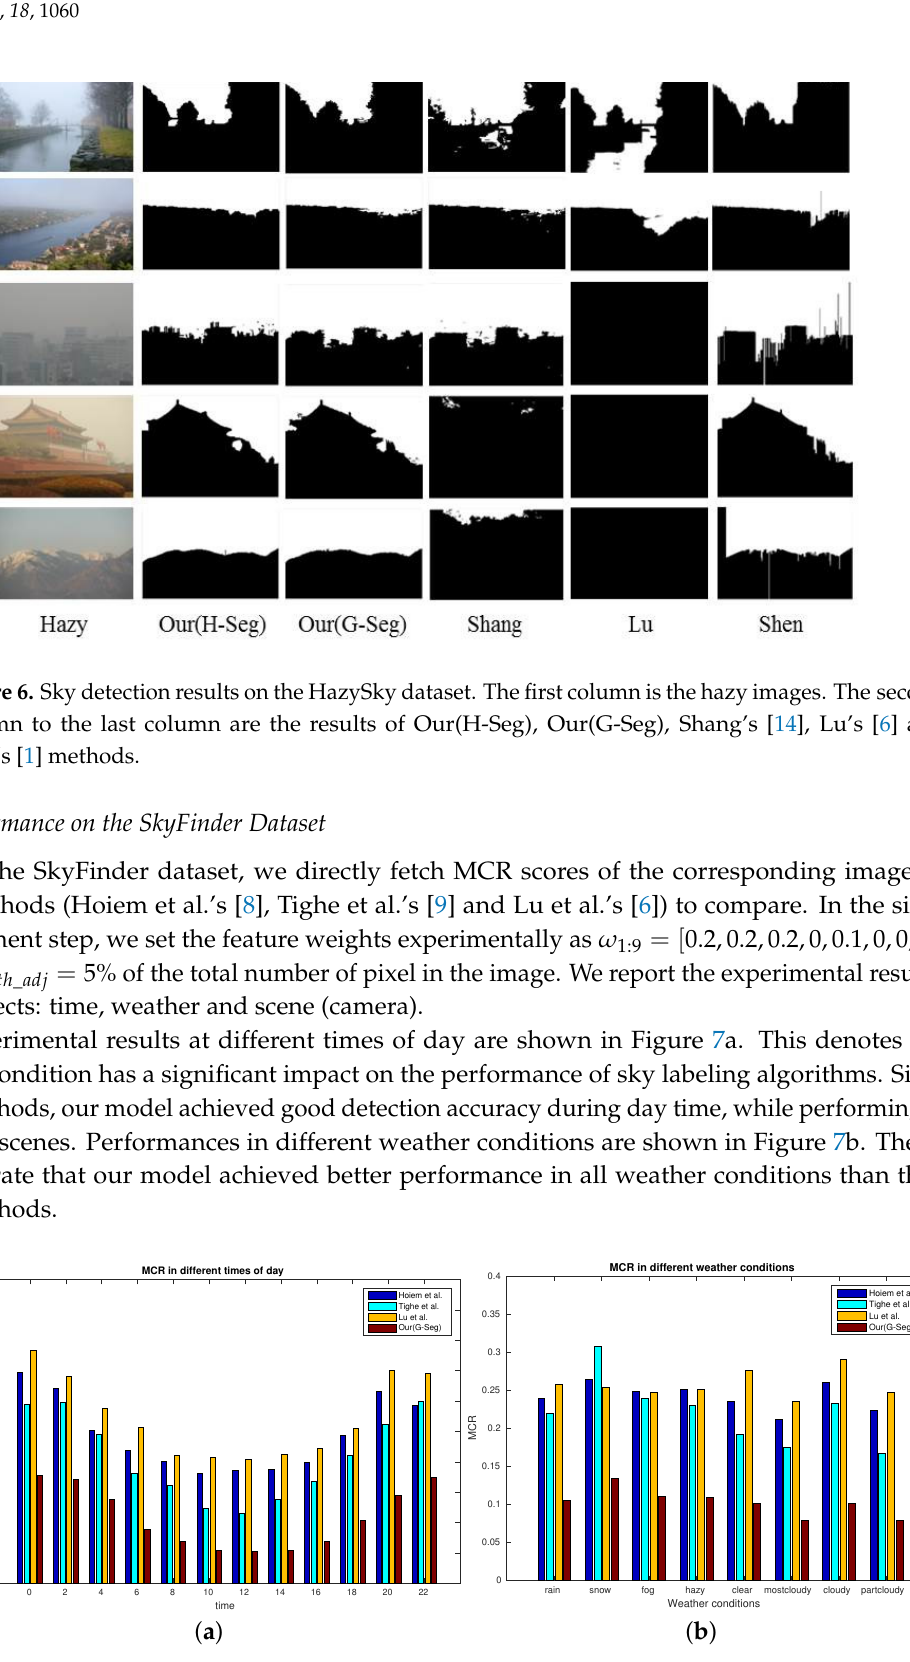
Figure 7. Performance analysis of our model in different weather and lighting conditions. ( a ) MCR (MisClassificationRate) values at different times of day; ( b ) MCR values in different weather